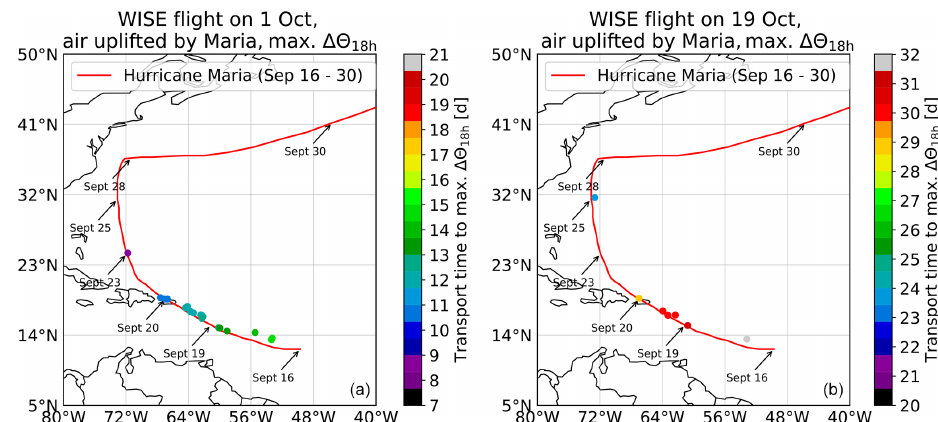
Figure 9. Trajectory locations of max (cid:49)(cid:50) 18h color coded with the transport time from the location of measurement to the position of max (cid:49)(cid:50) 18h along the trajectory. The red line indicates the storm track of the center of Hurricane Maria (Pasch et al., 2019) with arrows marking the location at which the hurricane resided on the indicated date. (a) Flight on 1 October; (b) flight on 19